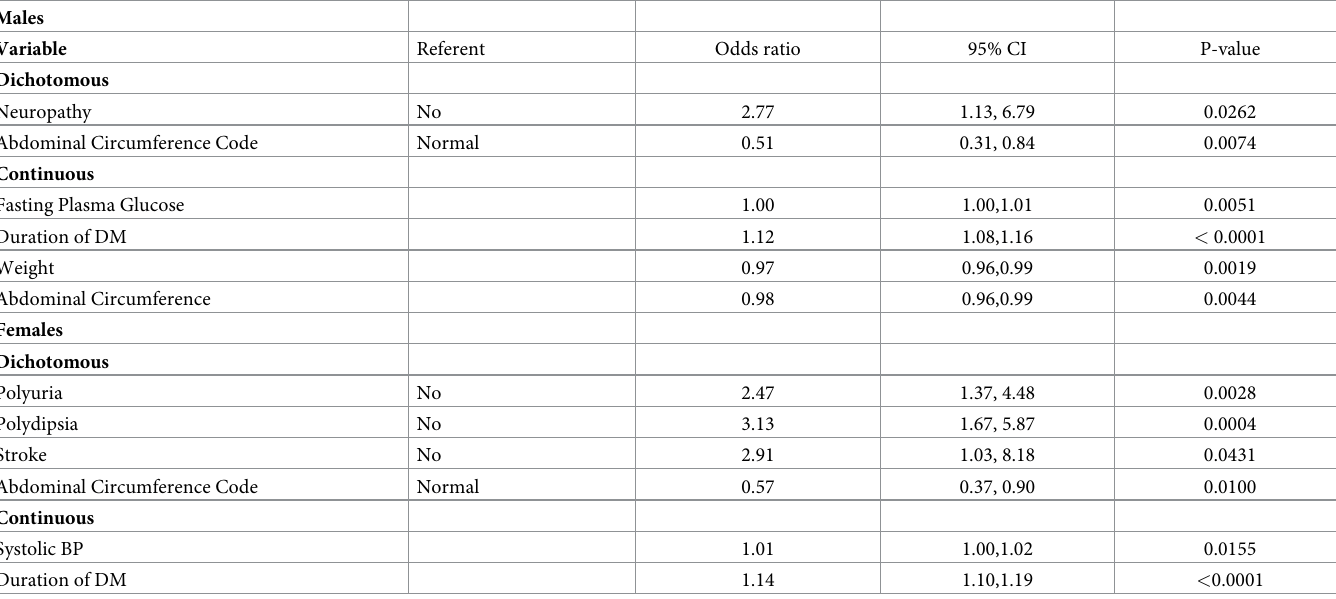
Table 4. Sex stratified analyses of DR association–univariate